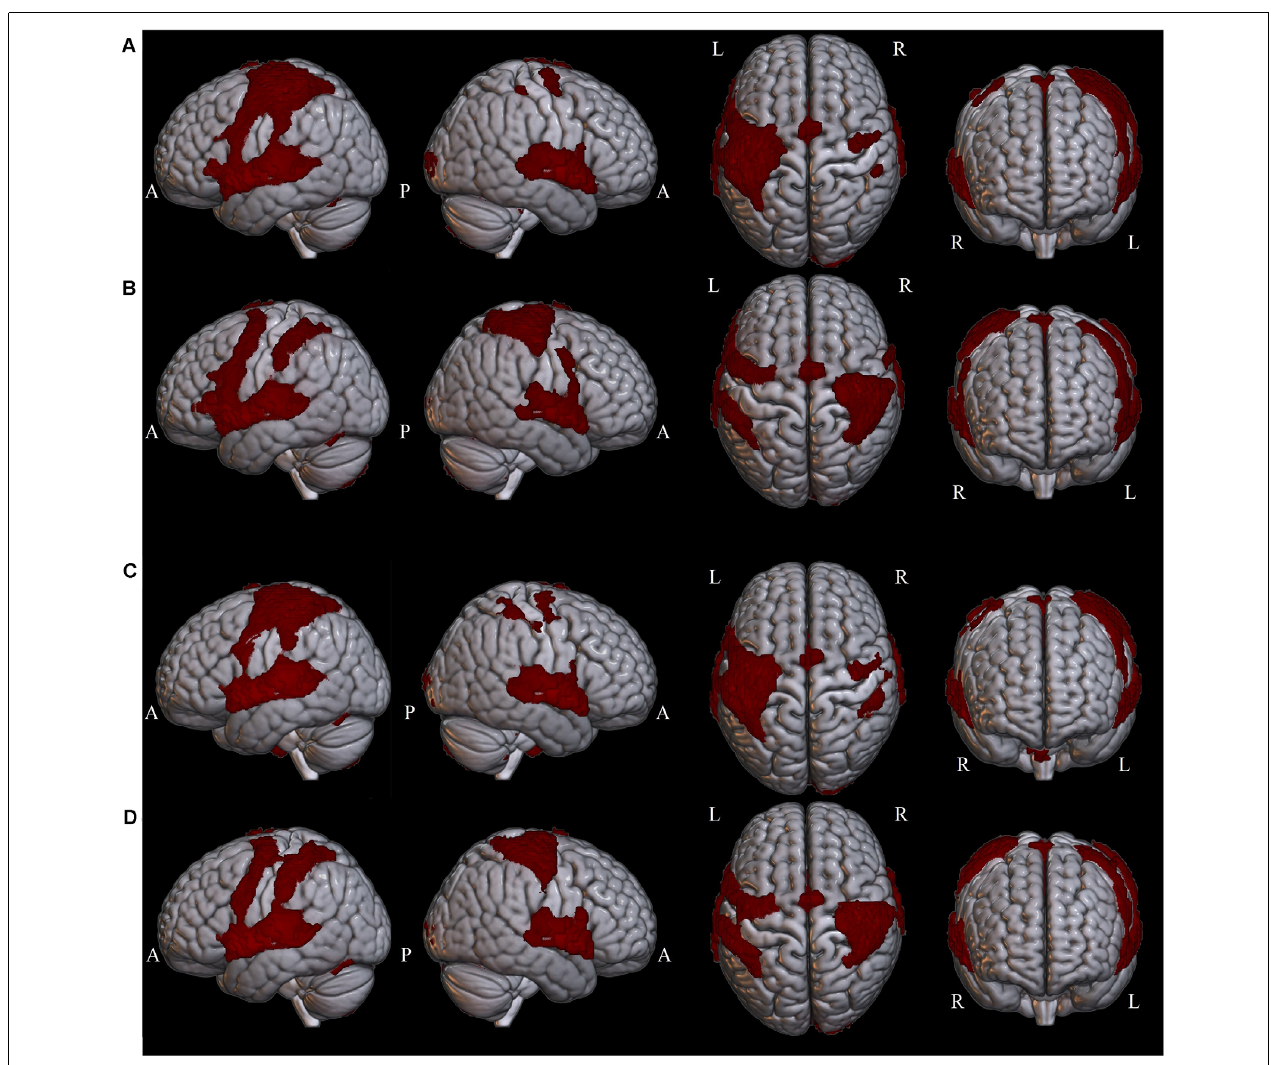
FIGURE 2 | Whole-brain clusters are projected onto surface templates using MRIcroGL software in four conditions: (A) Grammatical L1, (B) Ungrammatical L1, (C) Grammatical L2, (D) Ungrammatical L2.